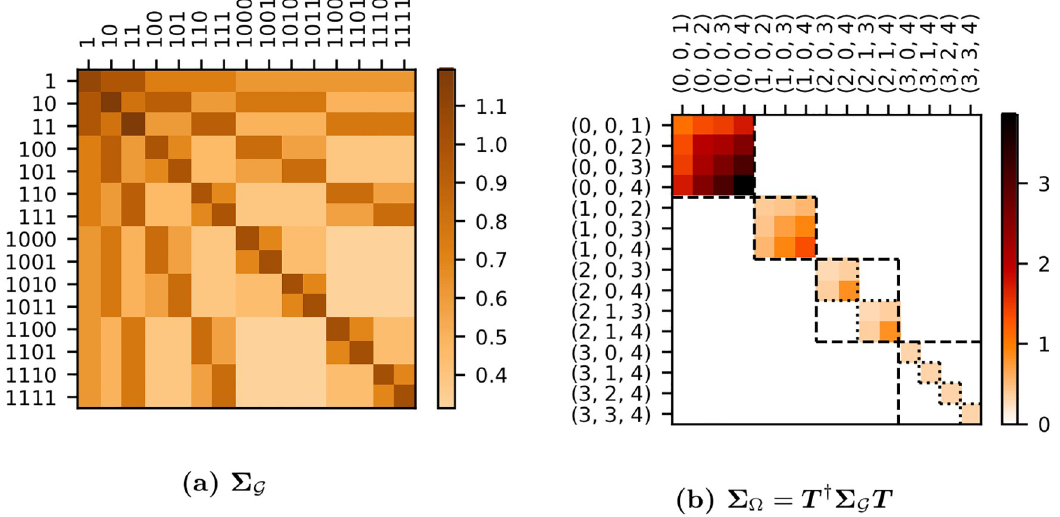
Fig 8. Heat maps of S and S O for a complete tree. This example was taken from the first 4 generations of the branching process. G Natural variables along the axes of S O are given in the format ( ℓ , τ , g ). Isotypic blocks are bounded by dashed squares and correspond to a given ℓ . Irreducible blocks correspond to a source of variation ( ℓ , τ ) and are bounded by a dotted square. For ℓ = 0 and 1 the isotypic and irreducible blocks coincide since there is only one τ index